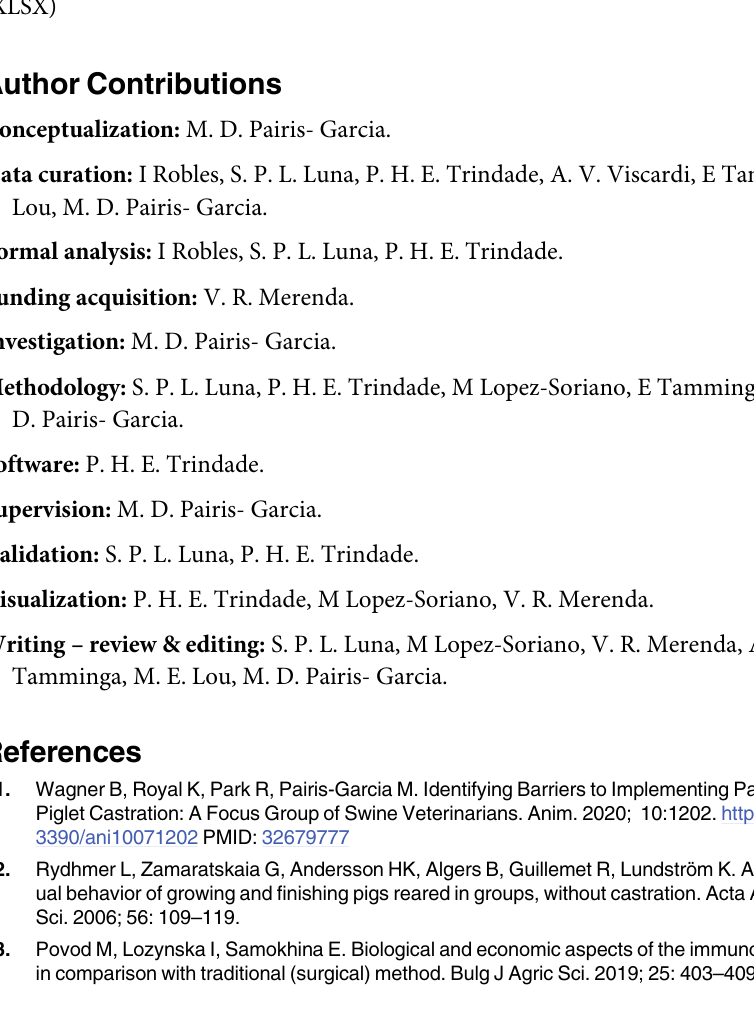
S3 Table. Median (amplitude) of the UPAPS scores before and after orchiectomy in all cas- trated piglets (n = 39). S4 Table. Median (amplitude) of the UPAPS scores before and after orchiectomy in cas- trated piglets awake (n = 14) during the assessment. S5 Table. Median (amplitude) of the UPAPS scores for castrated (n = 14) and non-painful female piglets (n = 6) awake piglets, after orchiectomy during the assessment. S6 Table. Item-total correlation and internal consistency of the UPAPS+nursing applied for all castrated piglets (n = 39). S7 Table. Item-total correlation and internal consistency of the UPAPS+nursing applied for castrated piglets awake (n =